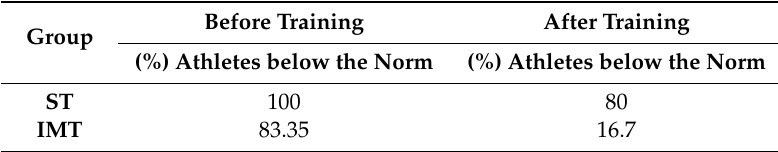
Table 7. The incidence of maximum inspiratory pressure disorders